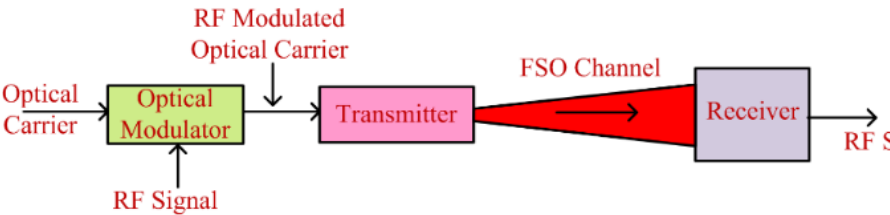
Figure 18. Simplified illustration of a Ro-FSO simplex system.